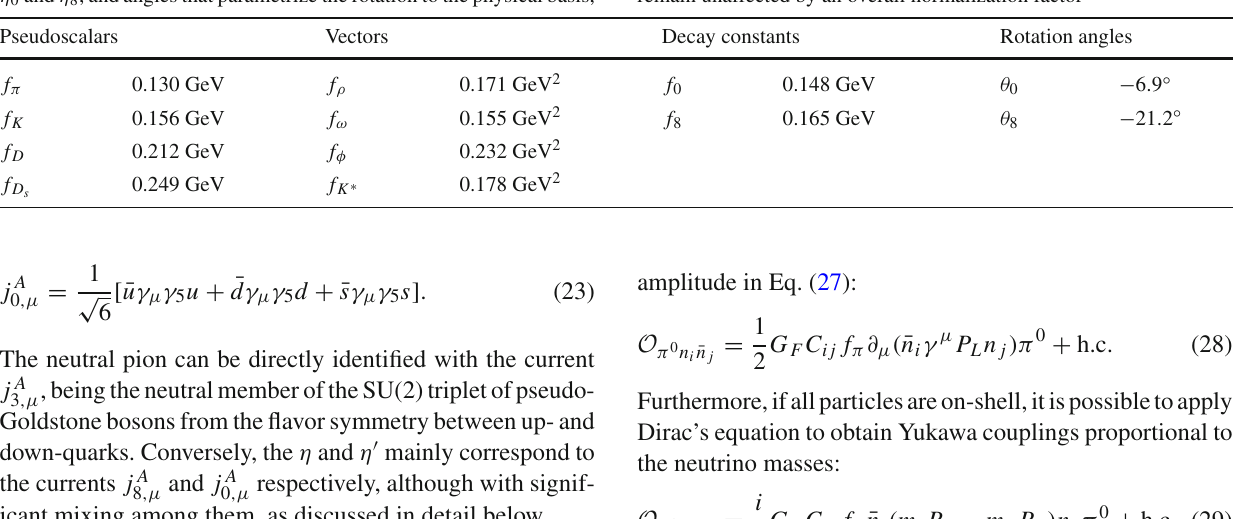
taken from Ref. [70] (see text for details). Note that in Ref. [70] the authors use a different normalization for the current definitions than the one adopted in this work. However, this does not affect our result since they provide their results in terms of the ratios f 8 / f π and f 0 / f π , which remain unaffected by an overall normalization factor